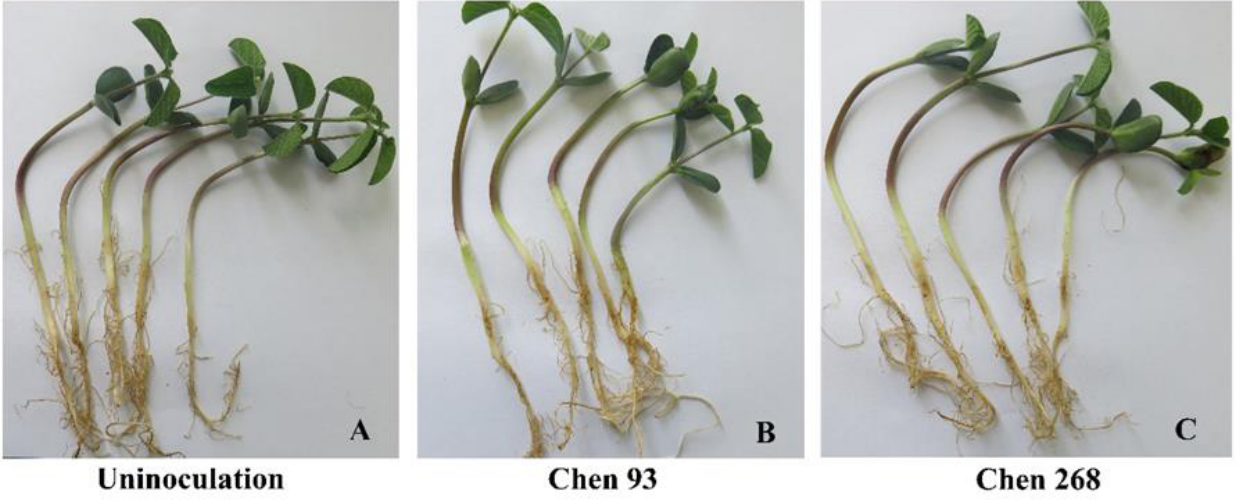
Figure 6. Pathogenicity of Globisporangium pengfuense and G. tenuihyphum isolates on the soybean cultivar Hefeng 47. ( A ) Control. ( B ) Disease symptoms caused by G. pengfuense (Chen 93). ( C ) Disease symptoms caused by G. tenuihyphum (Chen 268).